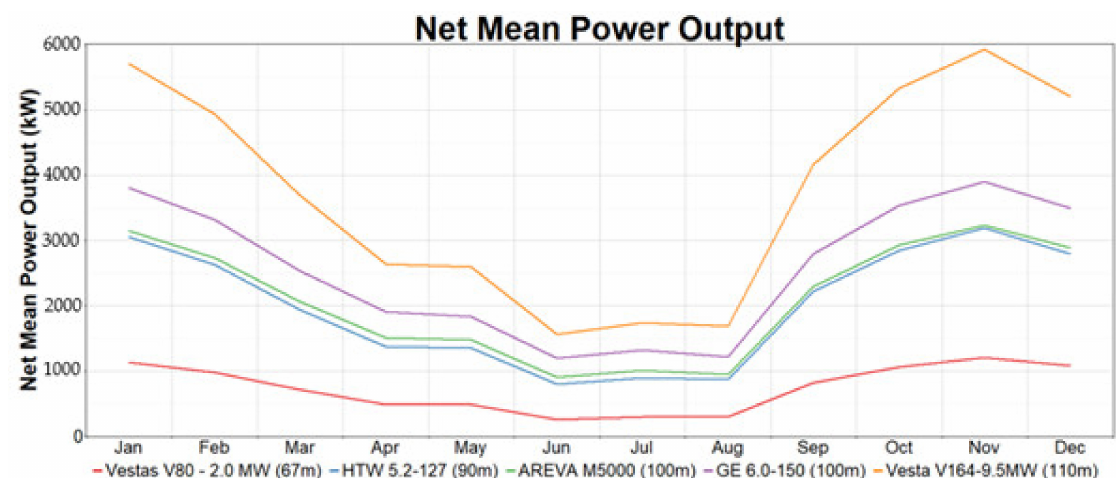
Figure 15. Summarized net mean power-output